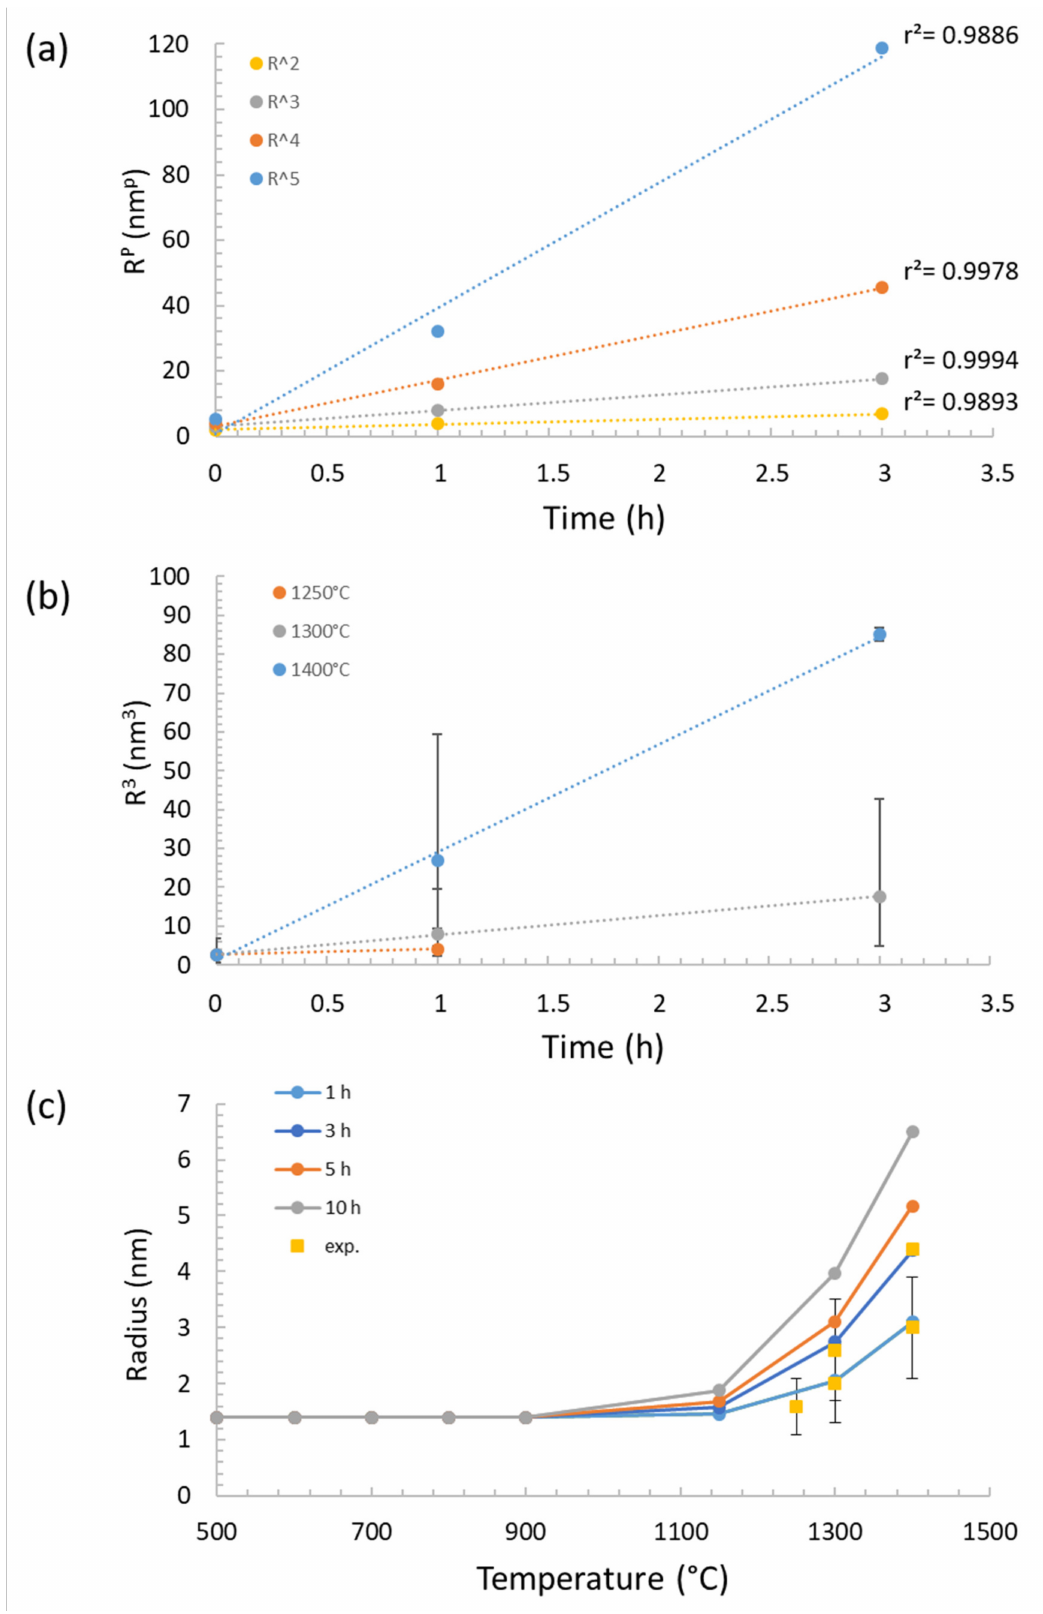
Figure 9. Ostwald ripening of the nano-oxides: ( a ) evolution of the radius elevated at the power p ( p = 2, 3, 4, 5) against time for a thermal annealing at 1300 ◦ C; ( b ) evolution of the cube radius against time for thermal annealing at 1250 ◦ C, 1300 ◦ C and 1400 ◦ C; ( c ) plot of the calculated and experimental radii against temperature for various annealing